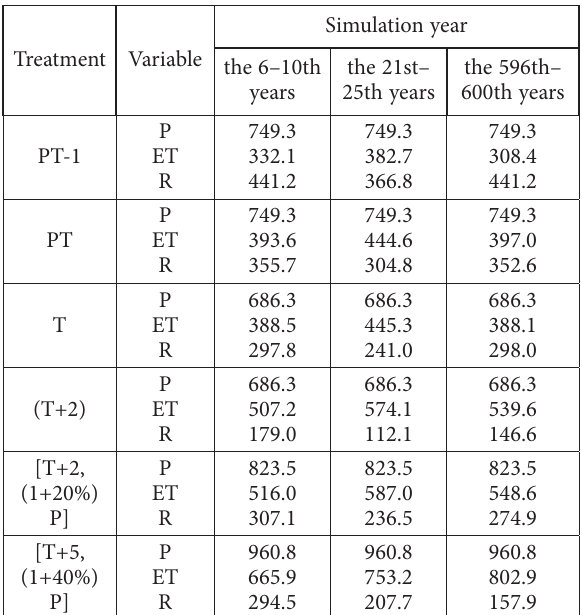
Table 2. Water balance of the basin during the three time periods